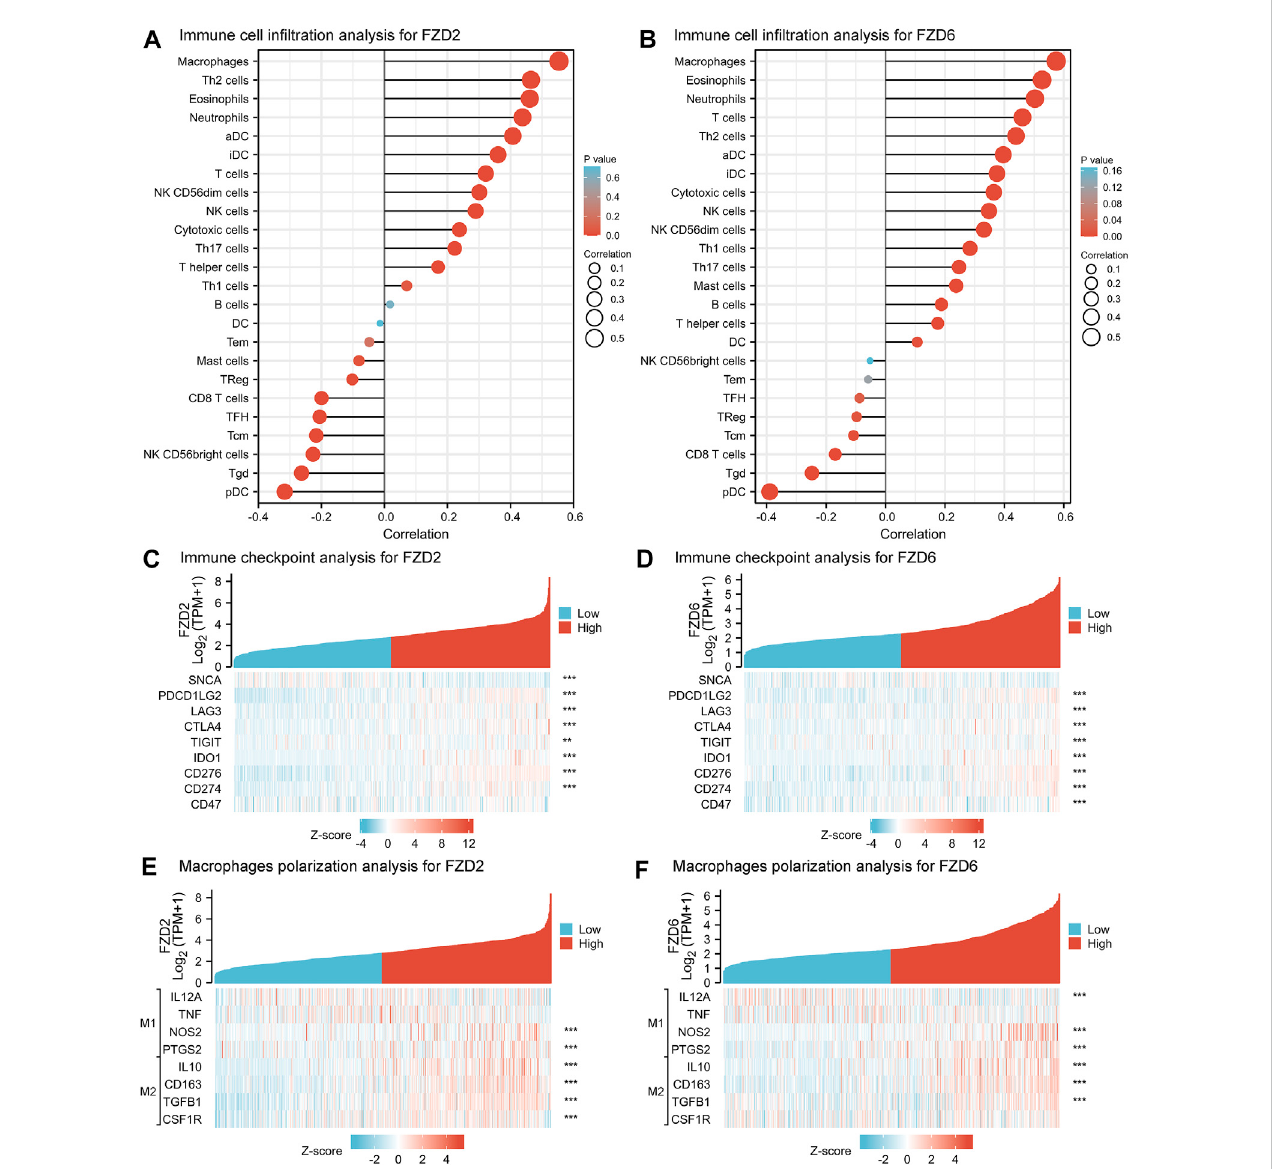
FIGURE 8 (A,B) Immunecellin fi ltrationanalysisofFZD2andFZD6. (C,D) ImmunecheckpointanalysisofFZD2andFZD6. (E,F) Macrophagespolarizationanalysisof FZD2 and